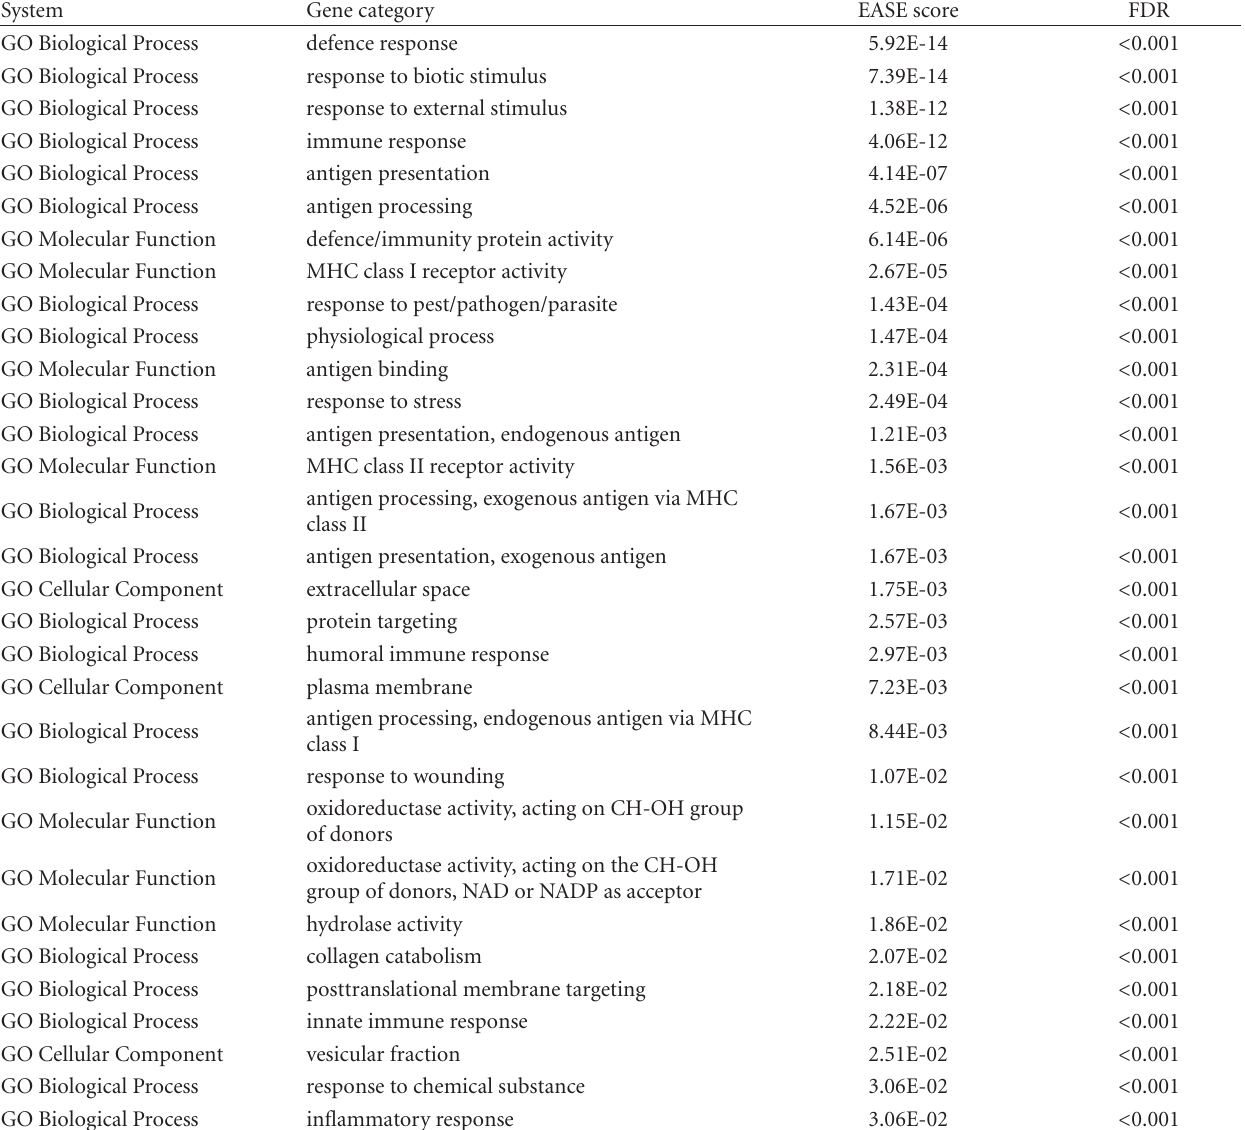
Table 8: Categories of genes with expression increase of 2-fold or more in Il10 − / − mice compared to C57 mice at 12 weeks of age using